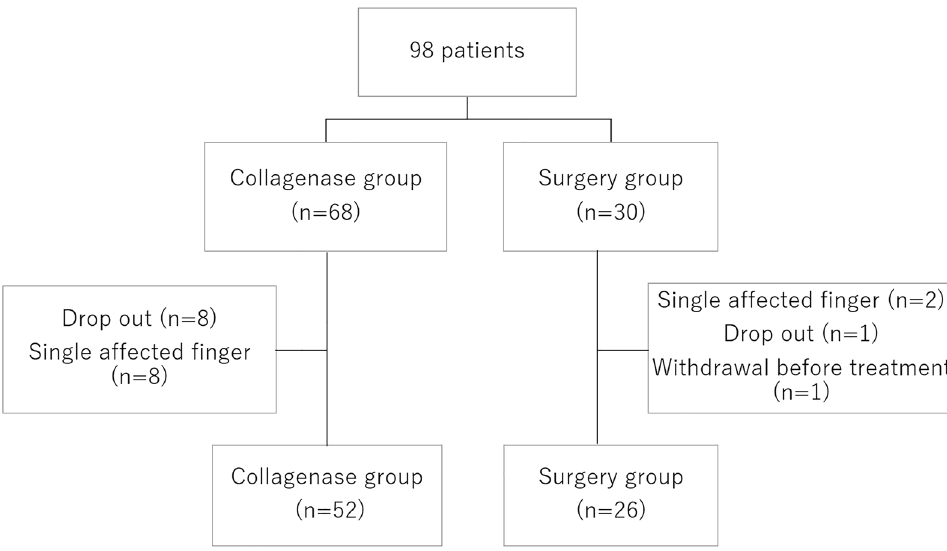
Figure 1. Study flowchart. Twenty patients were excluded because of single affected finger (n = 10), loss to follow-up (n = 9), or withdrawal before treatment (n = 1). n,